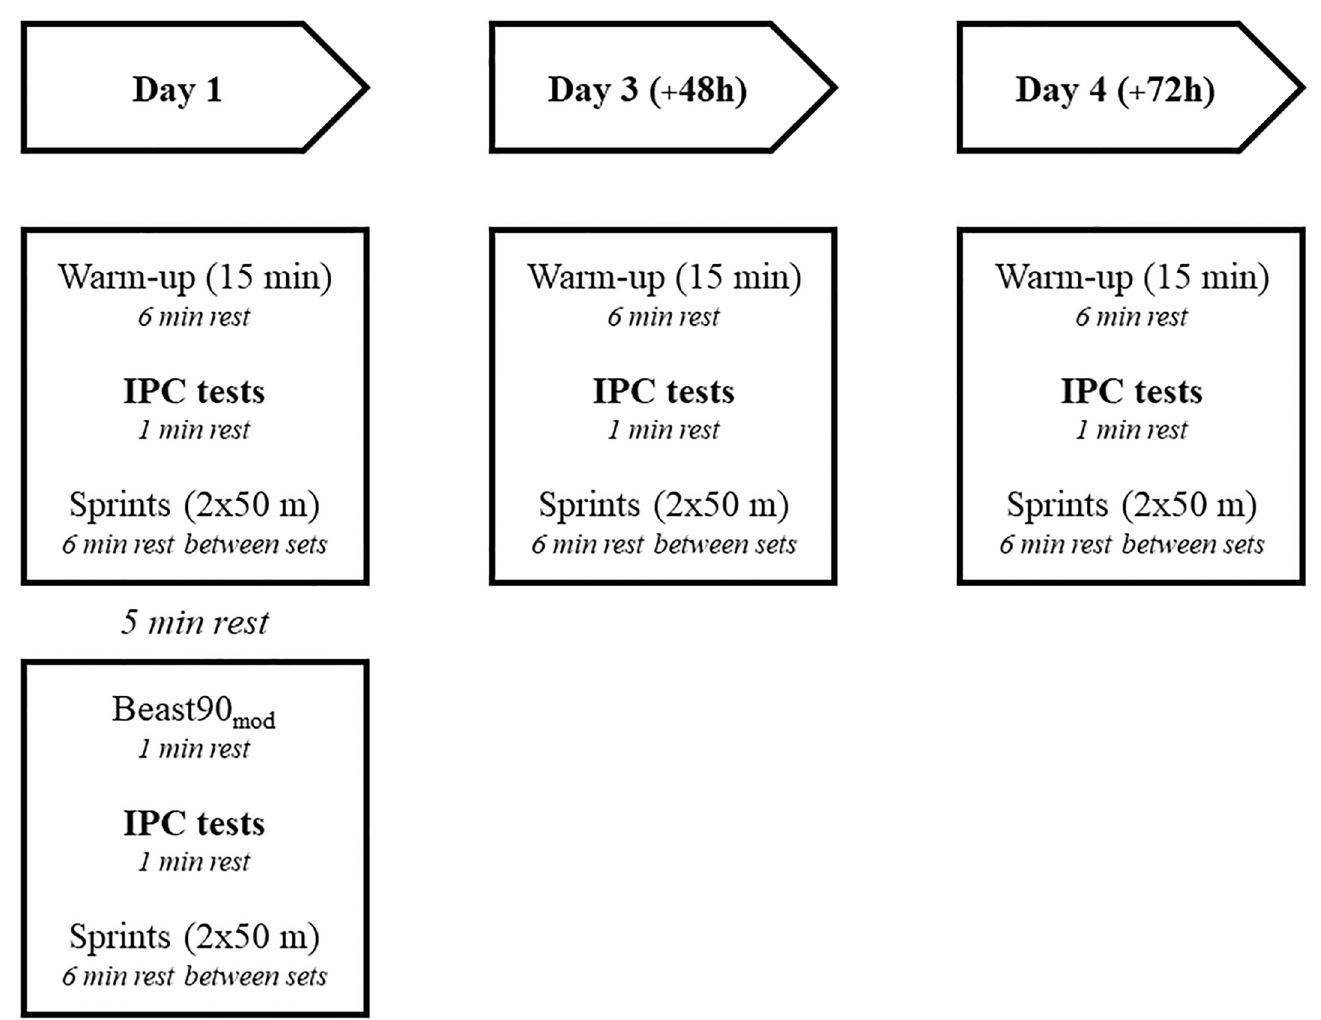
Fig 2. The sequence of activities. The 90:90 and 90:20